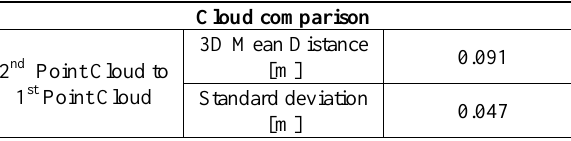
Table 5. Cloud comparison distance and standard deviation for the tested Point